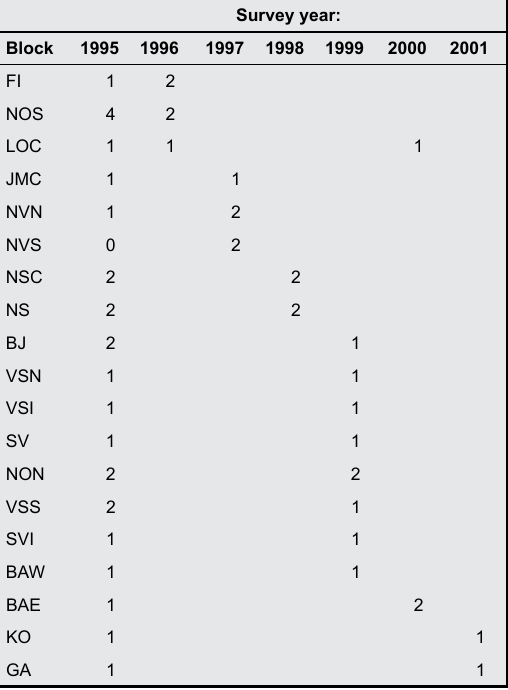
Table 1. Summary of block coverage over the survey period 1995-2001 in the North-eastern Atlantic by year and the number of vessels which conducted primary search effort within each